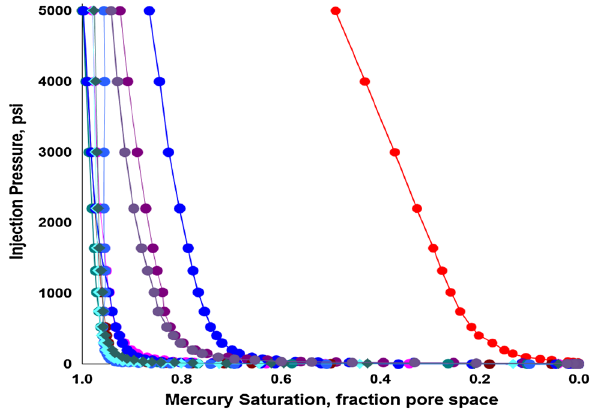
Fig. 2 Mercury injection capillary pressure curves obtained from the deep water turbidite